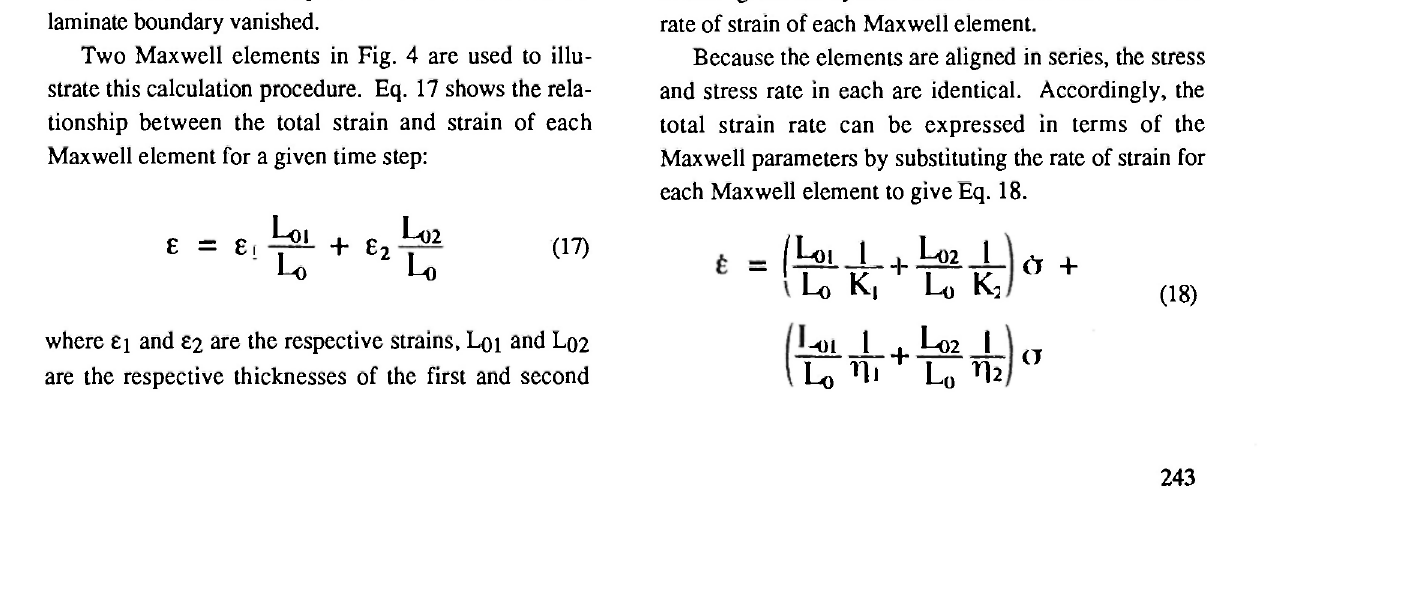
Fig. 3: Schematic illustrating the position dependence of the relaxation time in a layer exhibiting a temperature